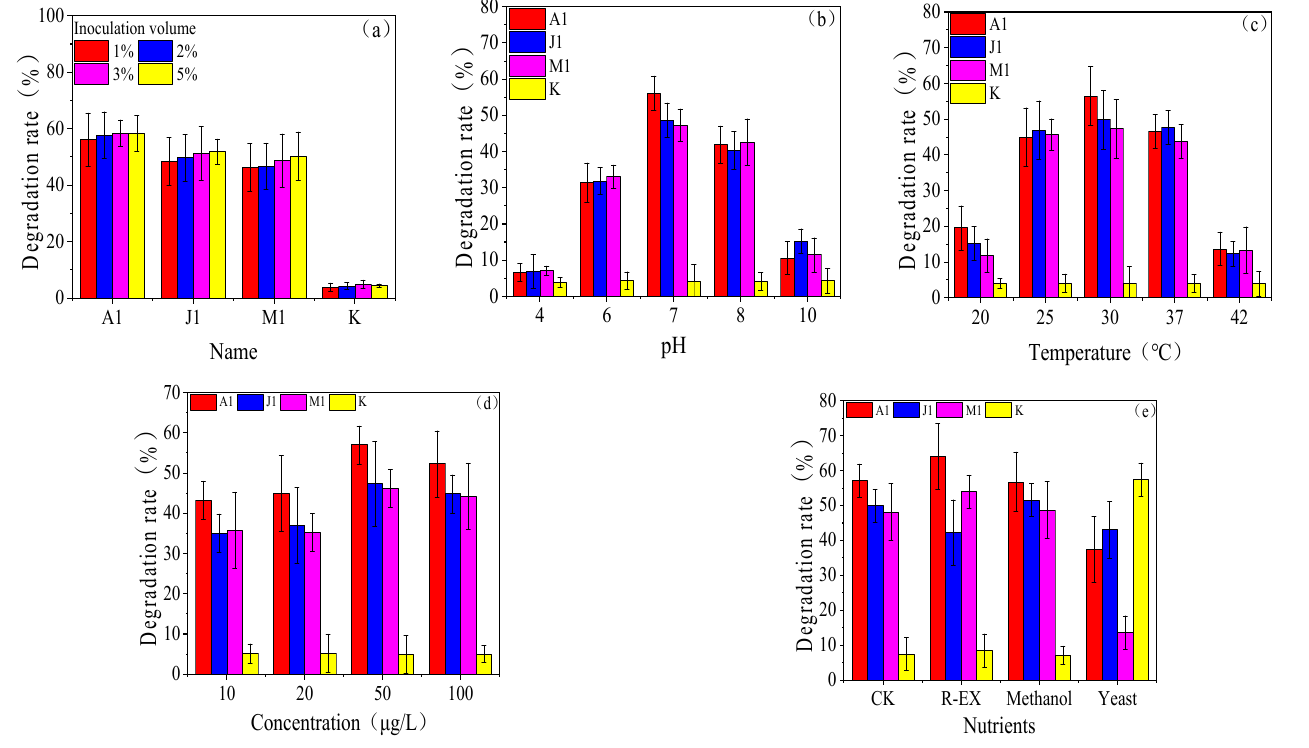
Figure 3. Degradation performance of β -HCH by strains at different levels of inoculum ( a ), pH ( b ), temperature ( c ), substrate concentration ( d ), and nutrients ( e ).